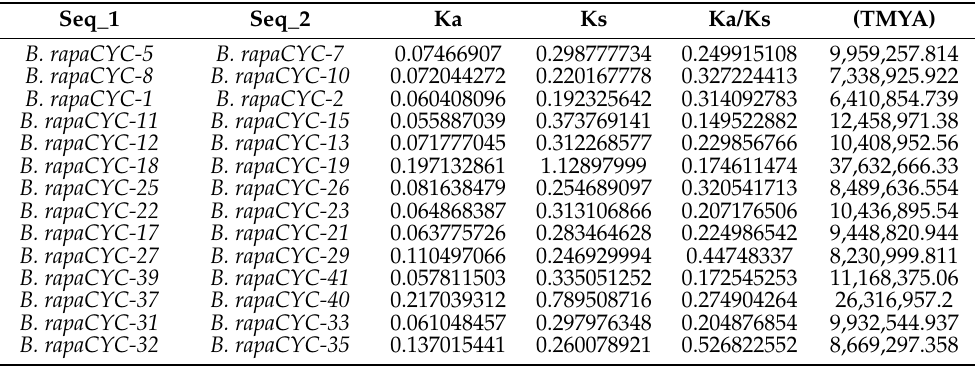
Figure 4 : ( a ) Circos figure for the chromosome locations with the Brcyclins segmental duplication links. ( b ) Brcyclin synteny study in Arabidopsis thaliana, Brassica napus, Brassica oleracea, Brassica juncea, Brassica carinata , and Brassica nigra . The syntenic cyclin gene pairs between the mentioned species are indicated by black lines. The gray line in the backdrop symbolizes the collinear blocks. Table 2. Ka/Ks value of the Brassica rapa cyclin genes.